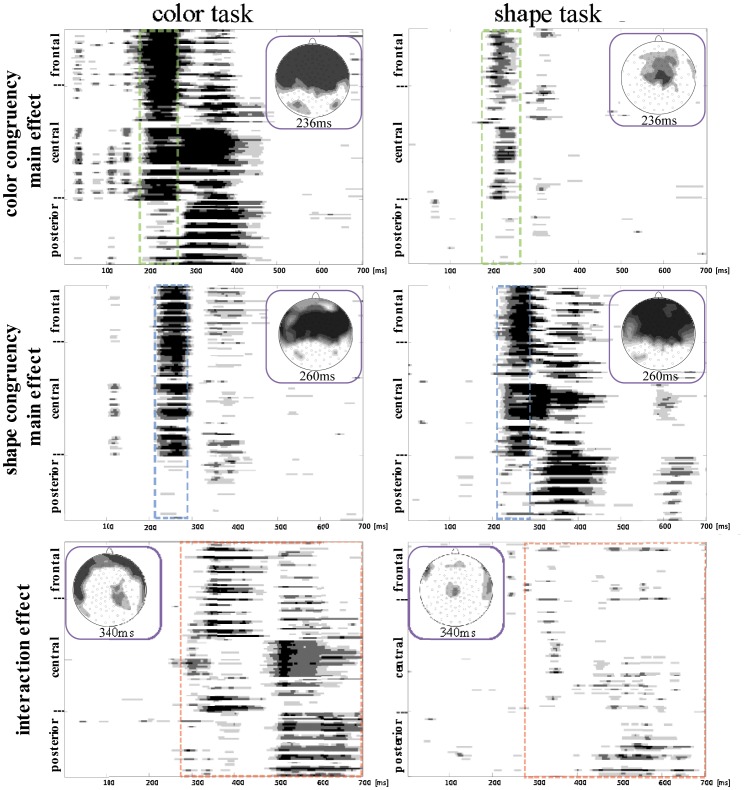
Statistical significance of 2(color congruency: match and mismatch) × 2(shape congruency: match and mismatch) ANOVA task at each time point at each electrode in the shape task and the color task.